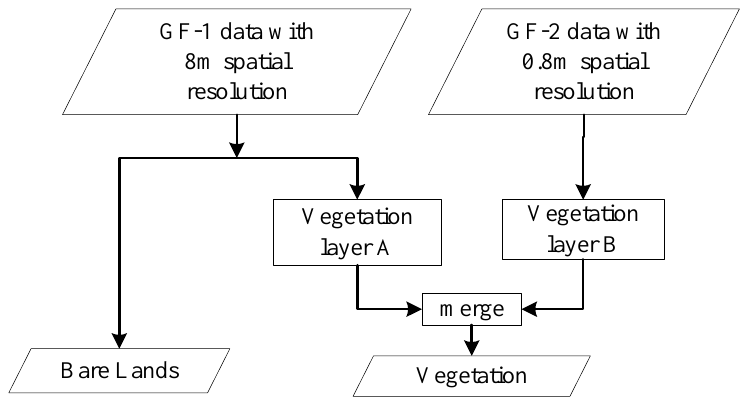
Figure 7. Flowchart for extracting vegetation and barren lands.